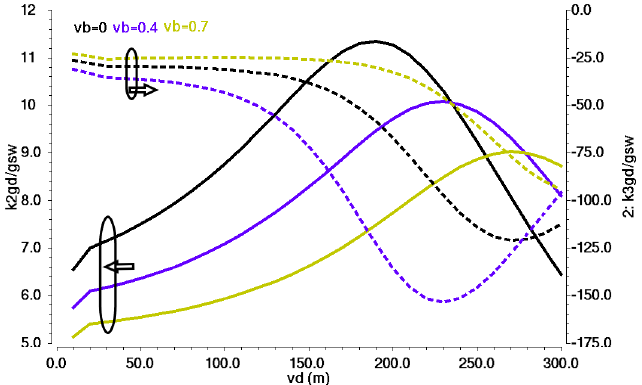
Figure 10. Simulation results of K 3 g